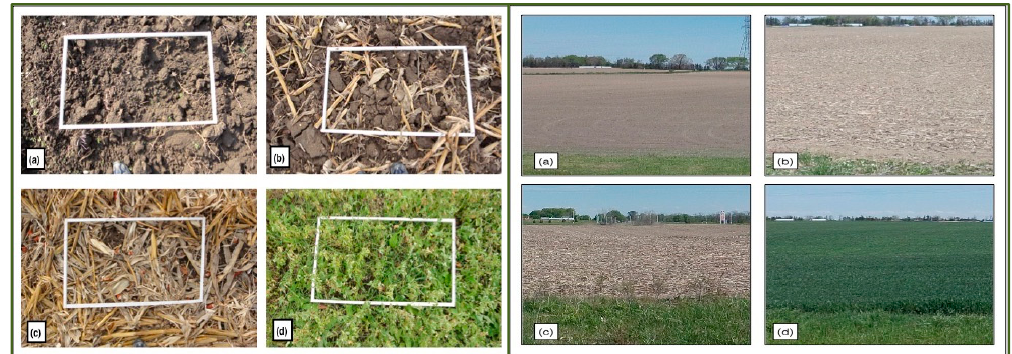
Figure 4. Non-growing season soil cover classifications shown from nadir (left) and oblique (right) vantage points. ( a ) illustrates conventional tillage practices with little visible residue (CV); ( b ) illustrates conservation tillage (CS) practices ( ≈ 30–60% residue); ( c ) presents no-till (NT) practices with greater than 60% residue; ( d ) illustrates green cover (GC) classification.